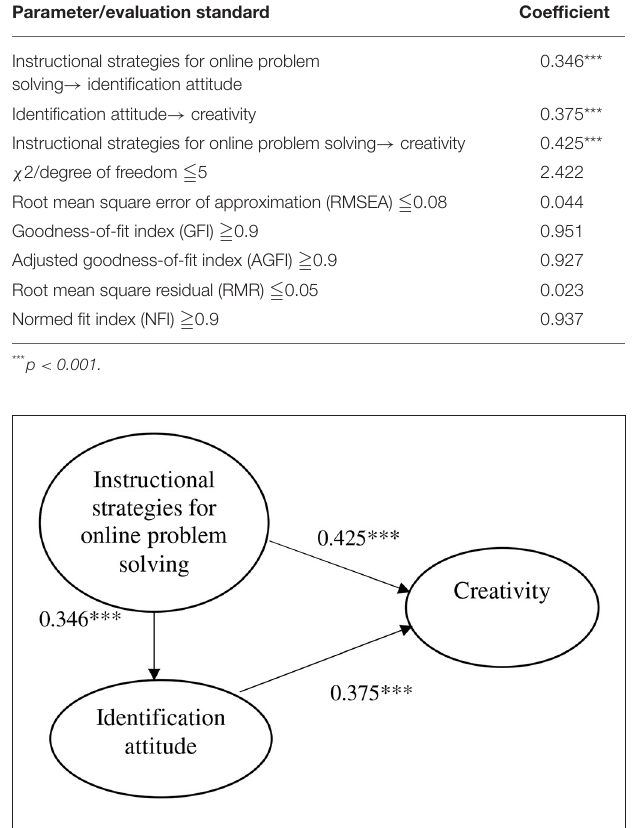
FIGURE 1 | FigureModel path